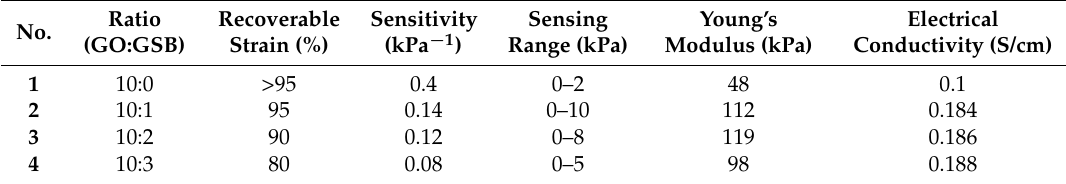
Figure 2. ( a , b ) Scanning electron microscopy (SEM) images of three-dimensional graphene composite foam (GSBF) (10:1), insert of ( a ) is the photograph of GSBF with different ratios of graphene oxide (GO) to graphene-SiO2 balls (GSBs) (the ratio of GO to GSB is 10:0, 10:1, 10:2, 10:3 from left to right). ( c ) Low-magnification transmission electron microscopy (TEM) images of GSBF. ( d ) High magnification TEM images of GSBF. Table 1. The mechanical properties and electrical conductivity of three-dimensional graphene composite foam (GSBF) with different ratios.